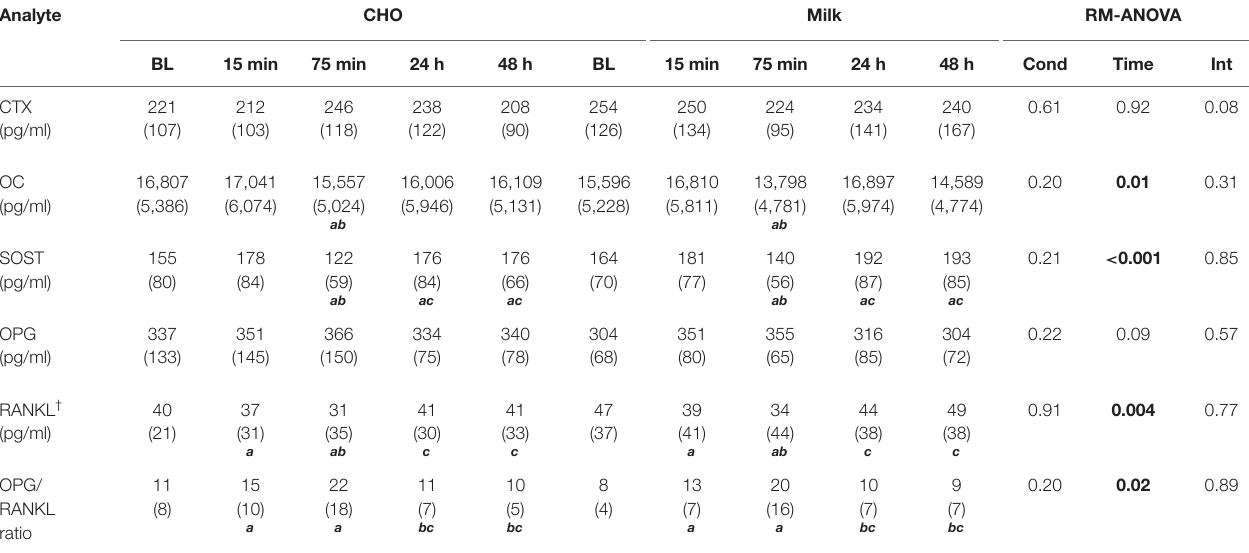
TABLE 3 | Absolute serum concentrations of bone biomarkers pre- and post-exercise during the carbohydrate (CHO) and milk (MILK) trials. Analyte CHO Milk RM-ANOVA